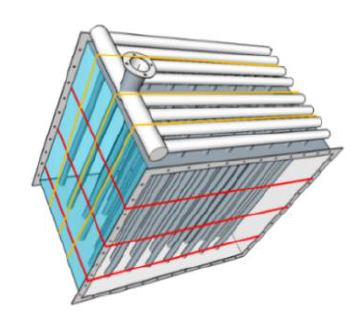
Figure 6. Schematic of the section position of the granular bed.